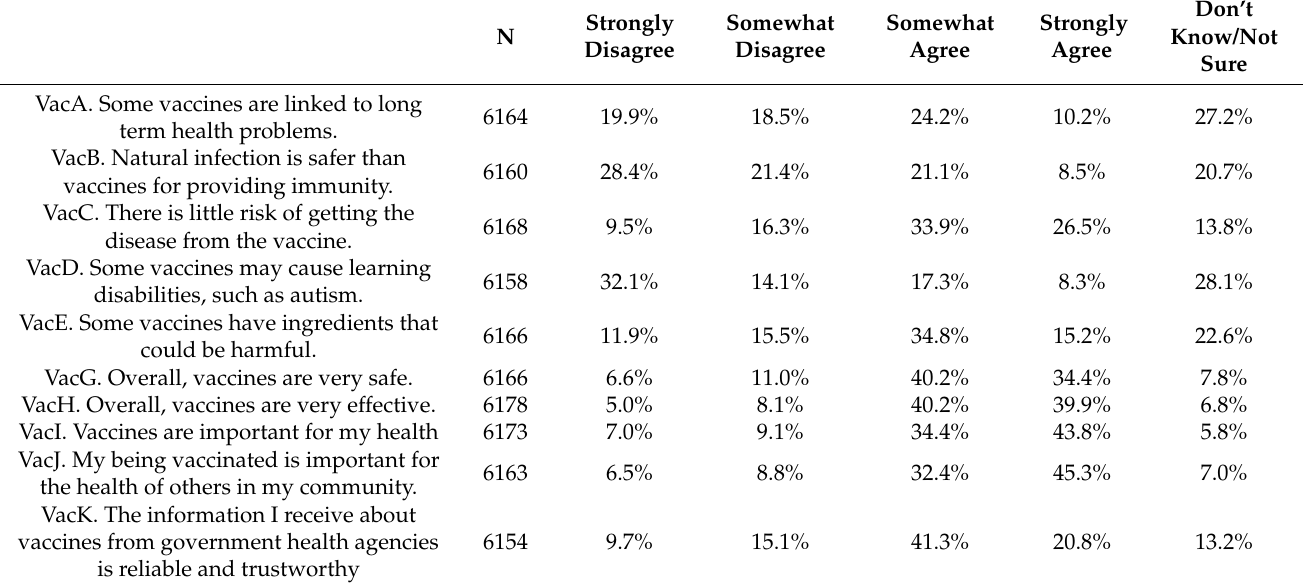
Table 3. General beliefs toward vaccines